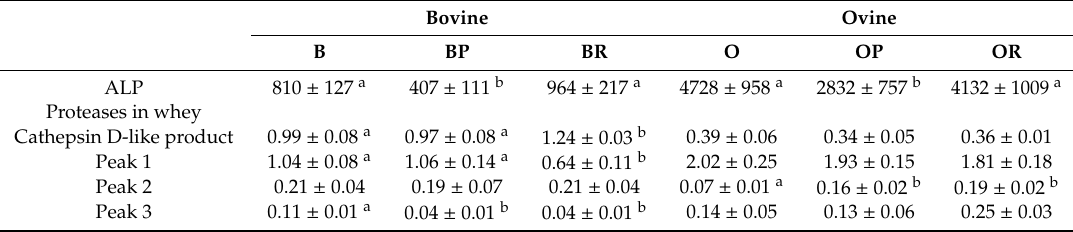
Table 4. E ff ect of microfiltration on alkaline phosphatase (ALP) activity ( µ g phenol / mL) and protease activities (area × 10 6 of peaks of RP-HPLC) in the whey fraction of partially defatted bovine (B) or ovine (O) milk, bovine permeate (BP), bovine retentate (BR) (mean ± SD, n = 3), ovine permeate (OP) and ovine retentate (OR) (mean ± SD, n = 5). Bovine